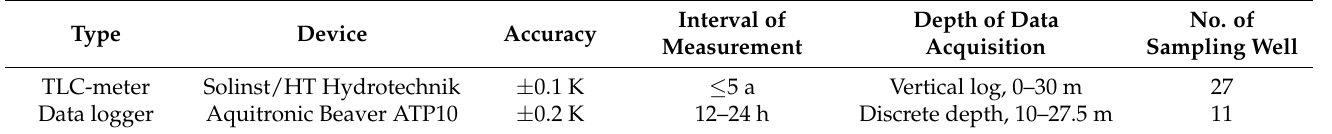
Table 2. Types of data collection and specifications of the devices in